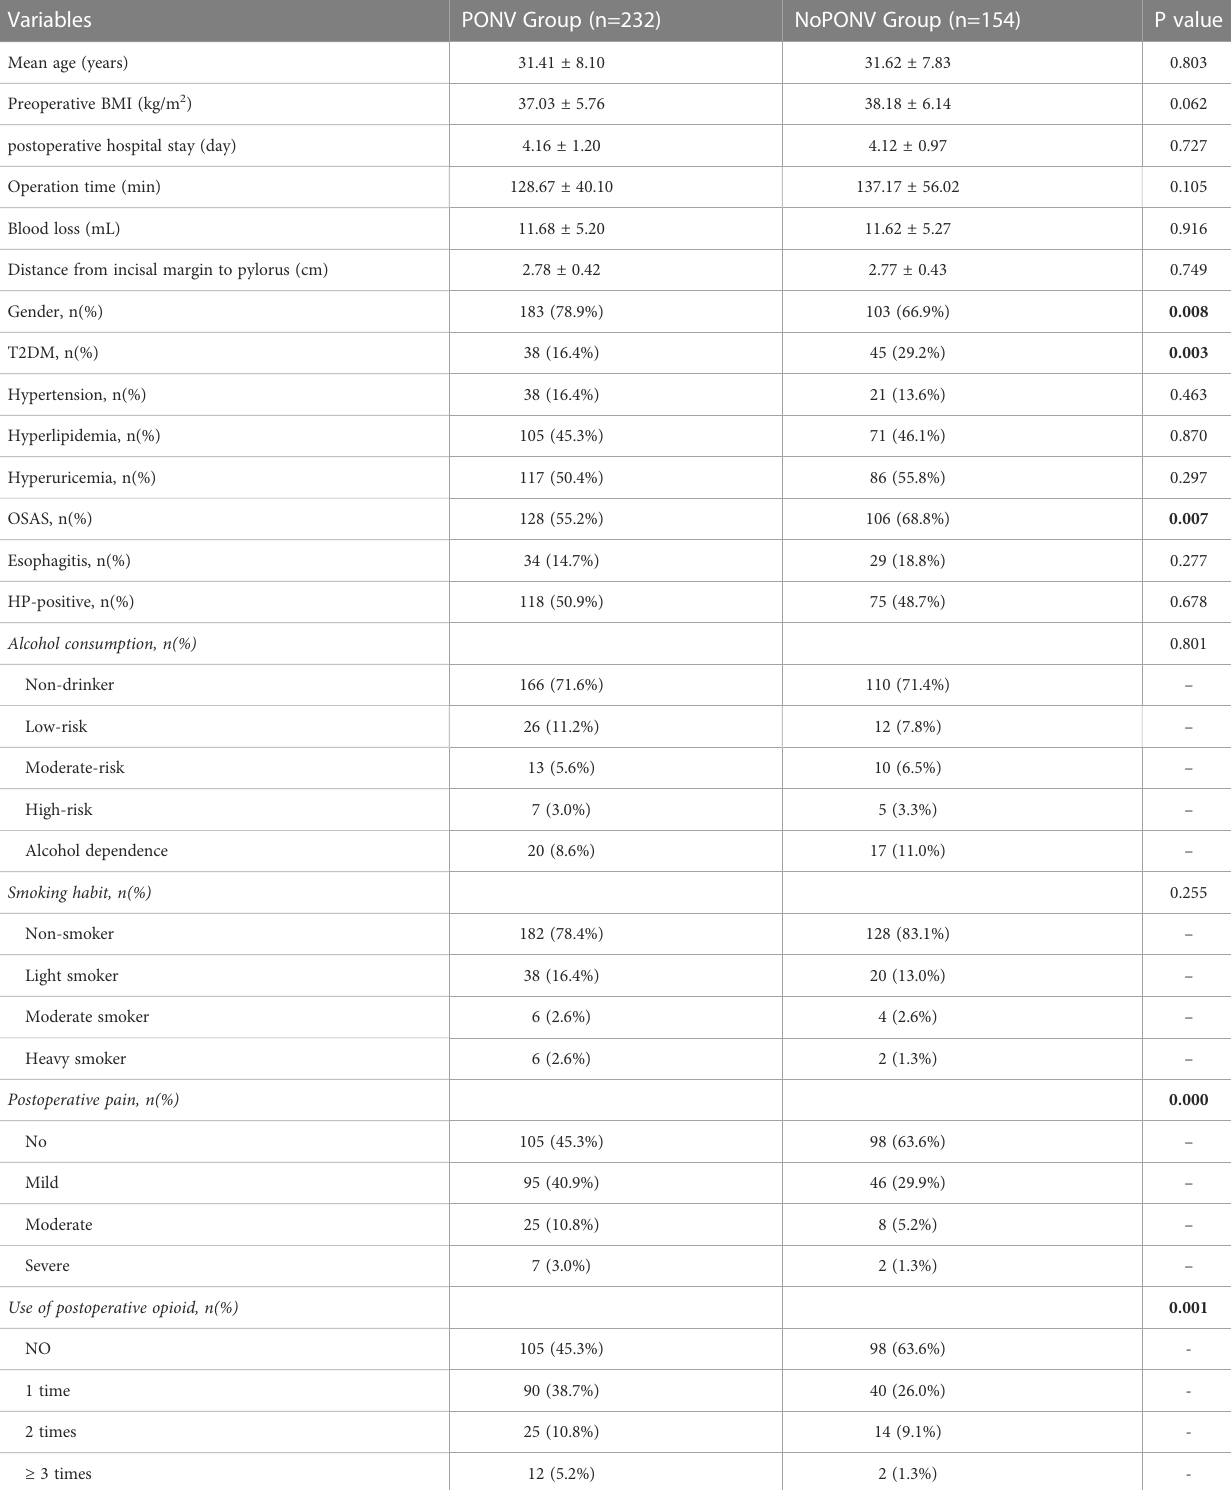
TABLE 4 Univariate analysis of PONV after LSG (after